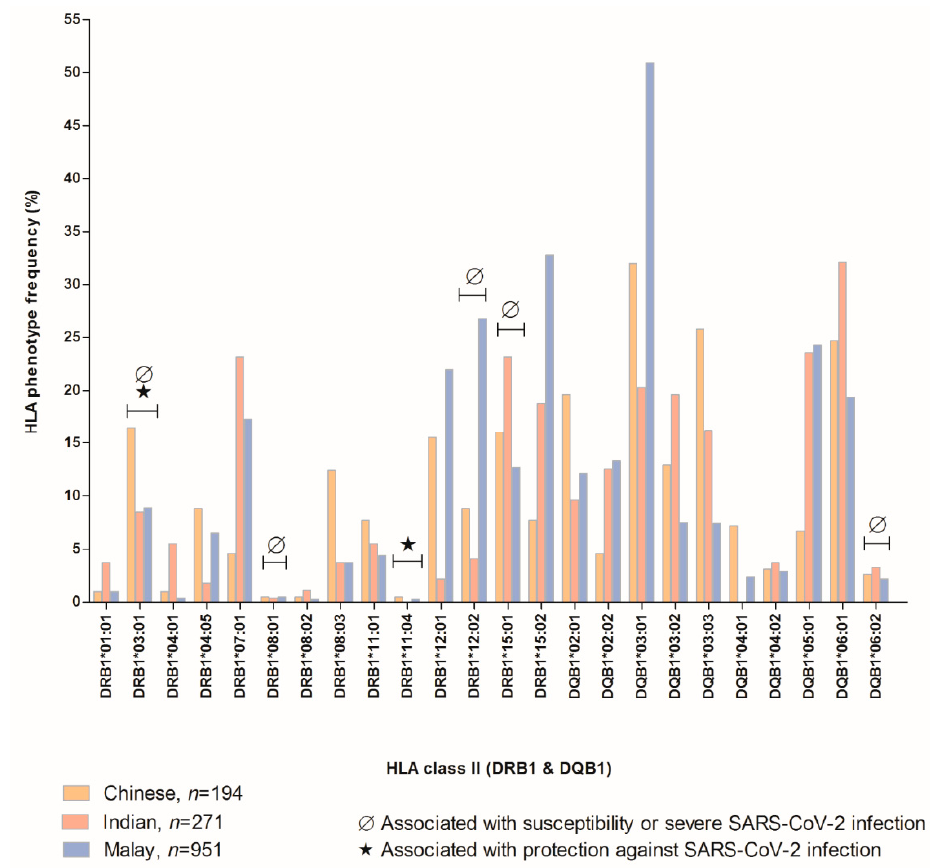
Figure 1. HLA class II phenotype frequency in Malaysia Peninsular Chinese, Indian, and Malay populations extracted from allelefrequencies.net in corresponding to SARS-CoV-2 epitopes recognition. The HLA phenotypes were collected from reported bioinformatics, case-control, and cohort studies.